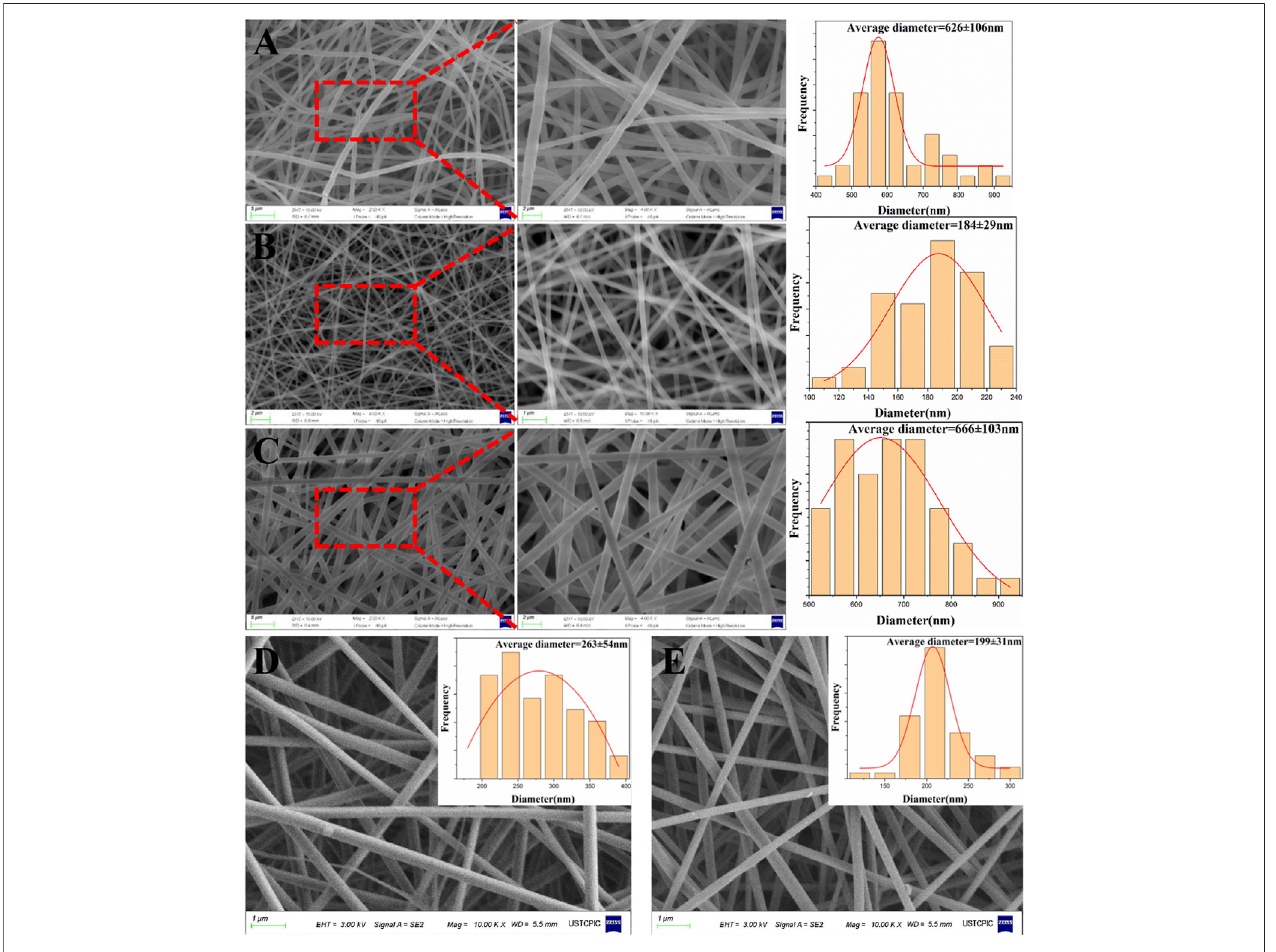
FIGURE 1 | SEM images and diameter distribution of PLA: PCL (A) , PVA (B) , ML-S (C) , PVA:MH (D) , and PVA:SSD (E) .